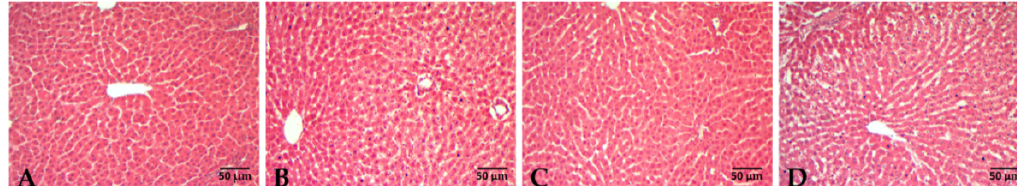
Figure 1. Liver histology at the end of reperfusion. Paraplast-embedded sections were cut at 7 µ m and stained with H&E. Panel ( A ) and ( C ): 60/60 and 60/120 min sham-operated rats, respectively. Panel ( B ) and ( D ): rats submitted to ischemia followed by 60 or 120 min reperfusion, respectively.